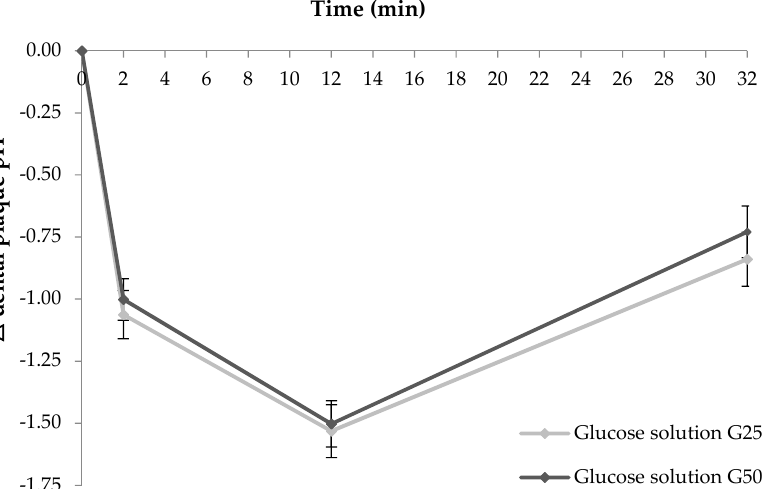
Figure 1. Change in postprandial dental plaque pH in response to two different doses of carbohydrate in 8 healthy adults. Data are mean ± standard error mean (SEM), n = 24 for the three repeated tests in each of the 8 participants for the glucose solution containing either 25 g available carbohydrate (shown in pale grey) or 50 g available carbohydrate (shown in dark grey).